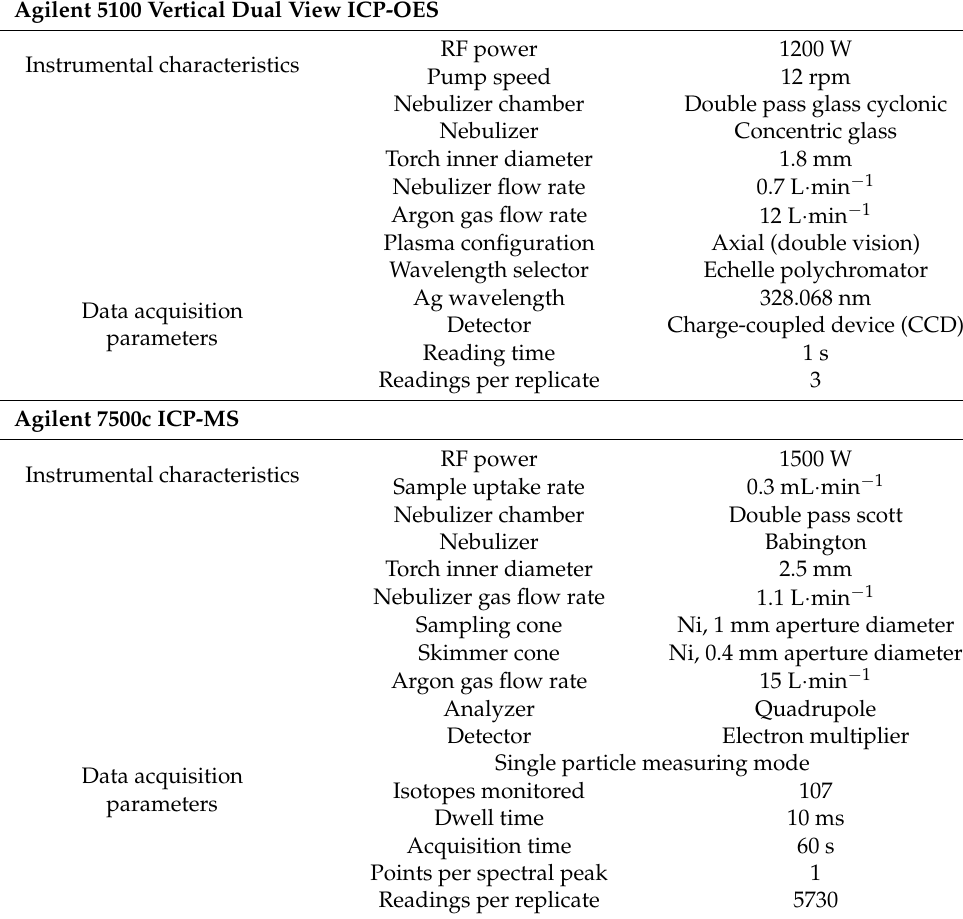
Table 2. Instrumental characteristics and measurement